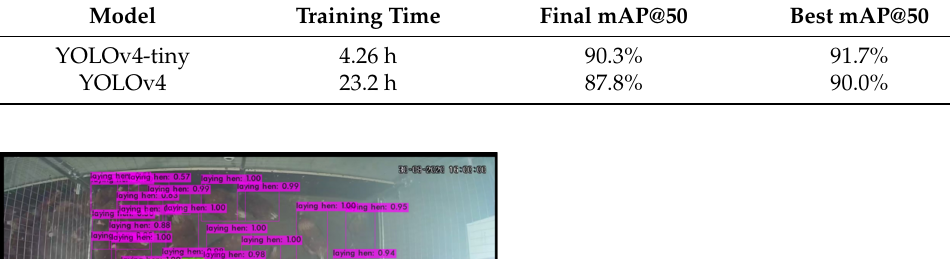
Table 1. Training time, final mAP@50, and best mAP@50 (area under the precision–recall curve with a